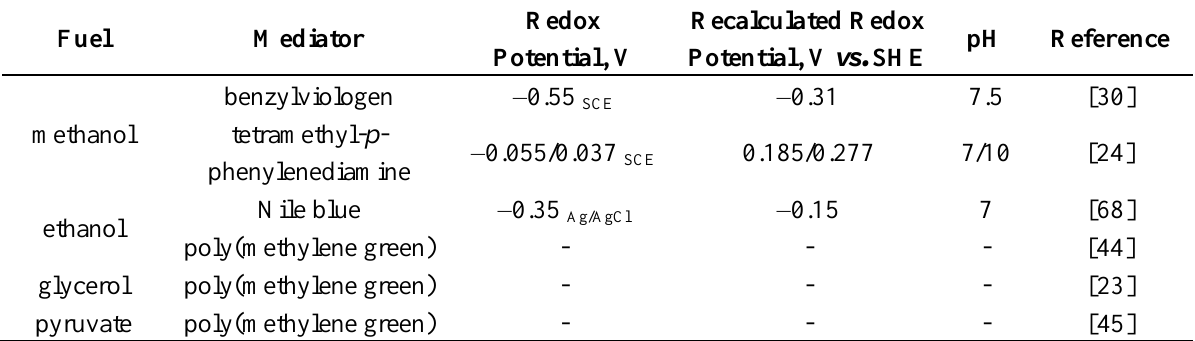
Table 5. Typical mediators for other fuels